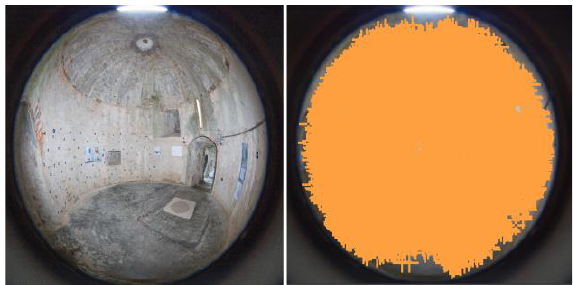
Figure 8: Result of 3D reconstruction for case 1 presenting a good texture and shape according to reality. Figure 6: Capture the dome of the castle with the fisheye lens and its points of passage after modeling the software with the calibrated image.